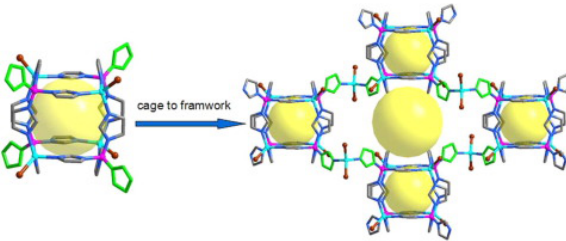
Figure 5. The illustration of the 3D BIF structure self-assembly according to the segmented cage technology. Reprinted with permission from